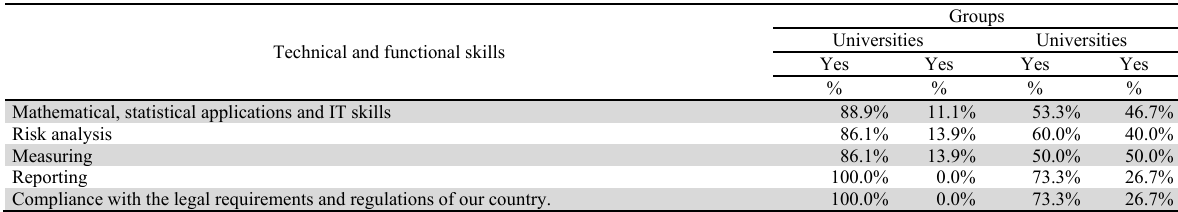
Technical and financial skills